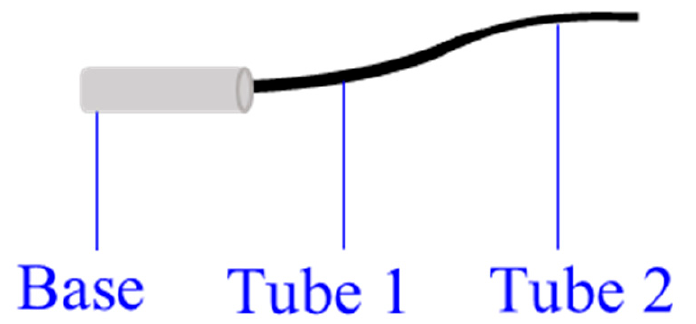
Figure 6. A two-tube concentric-tube CCR [76,77].